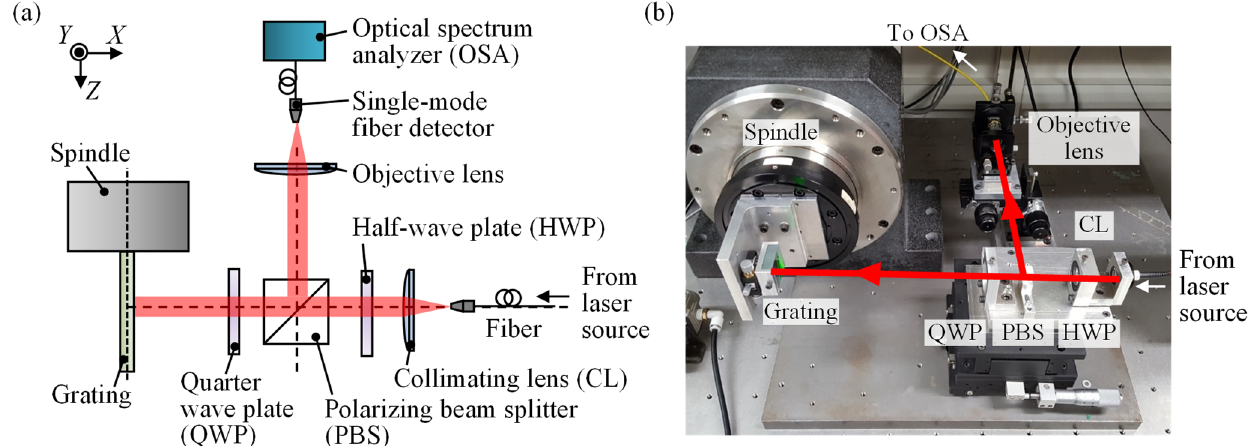
Figure 5. Experimental setup for measurement of the pitch of a reflective-type diffraction grating: ( a ) Schematic of the setup; ( b ) A photograph of the setup.